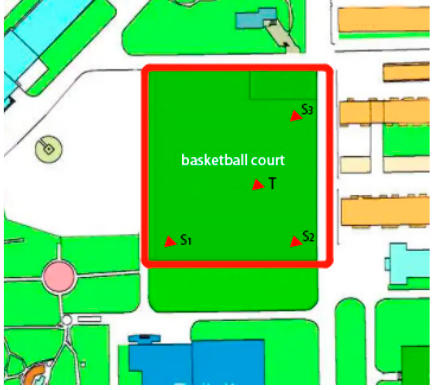
Figure 5. The basketball court environment.